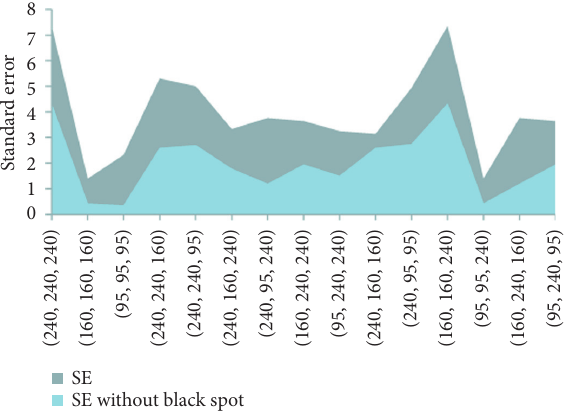
Figure 7: Measured standard errors of X , Y , and Z of HSI with different combinations of RGB.